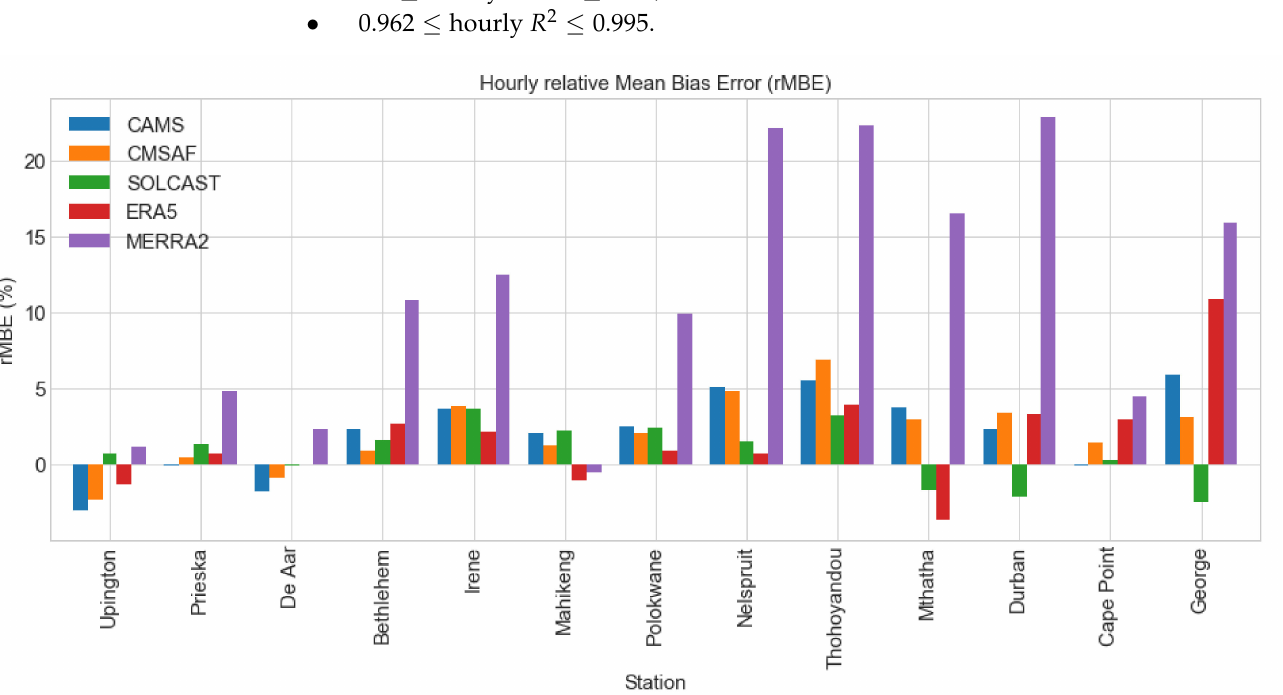
Figure 3. Hourly relative mean bias error of gridded datasets against measured in situ